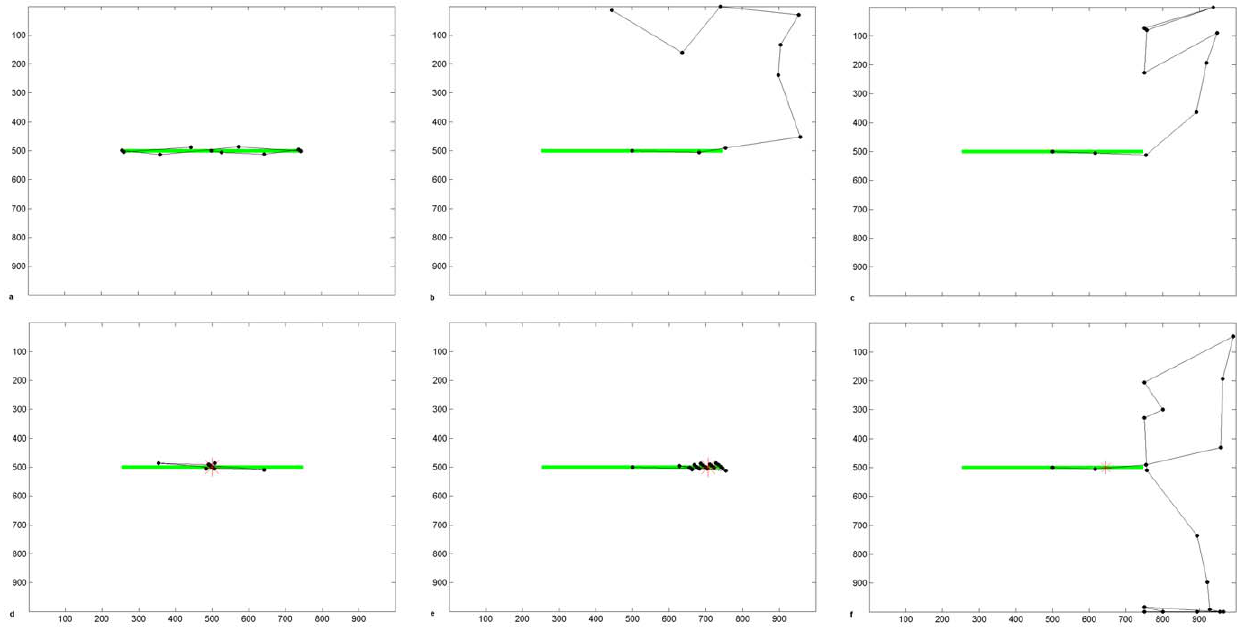
doi:10.1371/journal.pone.0054919.g004